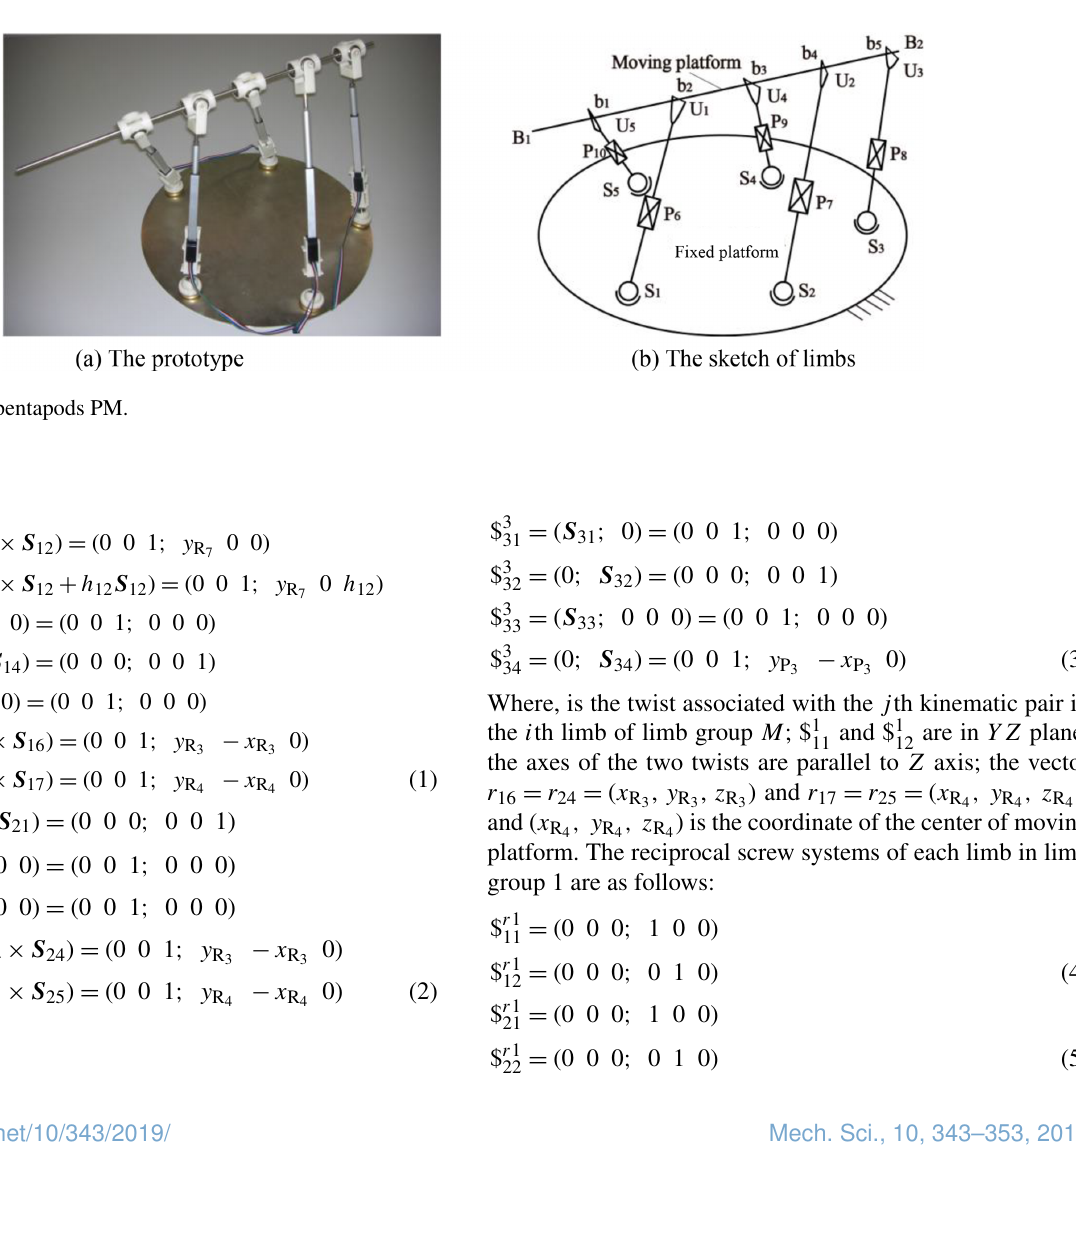
Figure 3. The 3-DoF PM with limbs of embedding structures.